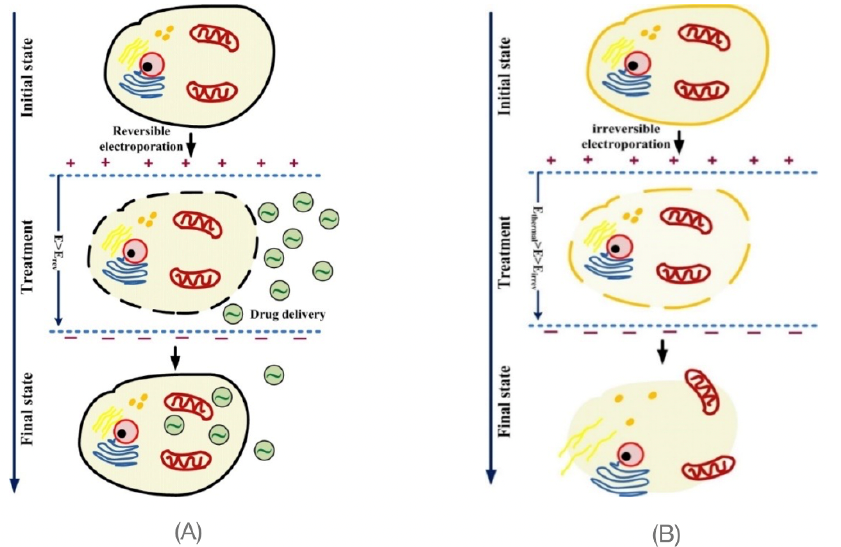
Figure 1. ( A ) Reversible electroporation process (Chen et al., 2007 [10]), ( B ) Irreversible electropora- tion process (Kee et al., 2011 [11]).